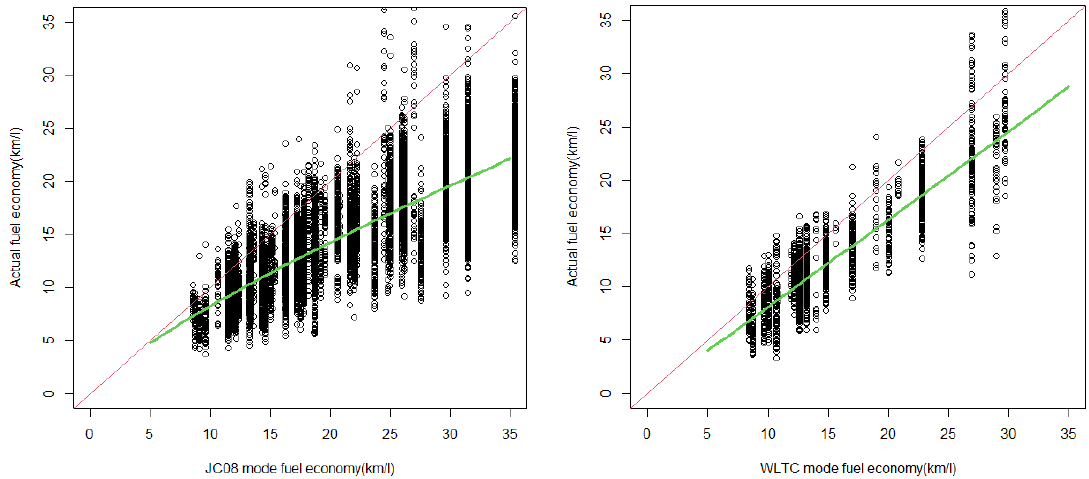
Figure 5. Scatterplot of actual and the JC08 mode ( left ) and the WLTC mode ( right ) fuel economy.